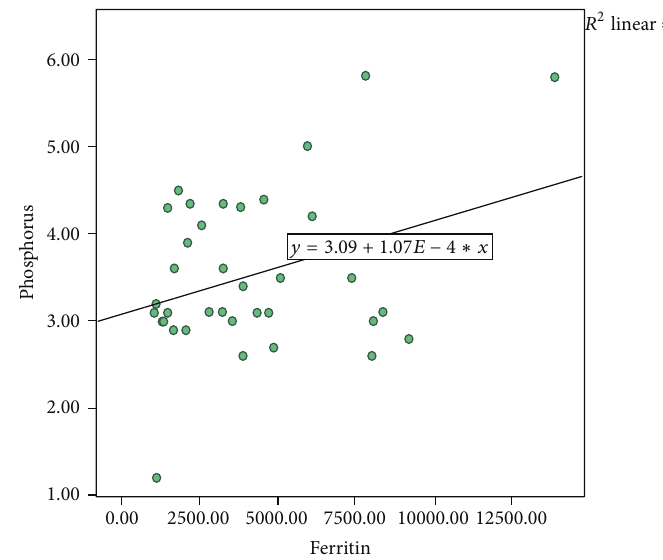
Figure 1: Correlation of serum ferritin and phosphorus ( 𝑃 = 0.04